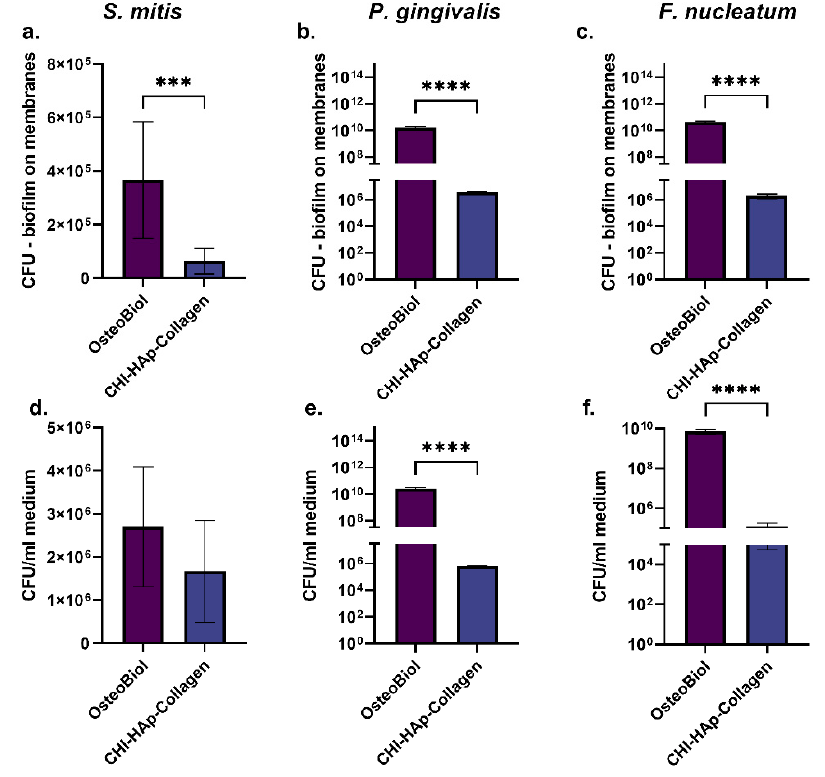
both types of collagen membranes showed signi fi cantly higher values of CFU on control membranes compared to CHI–HAp–collagen membranes for each monomicrobial bio fi lm (Figure 6). Additionally, the CFU count from the medium around both types of collagen membranes was higher for the medium around unmodi fi ed membranes for all species (results for P. gingivalis and F. nucleatum reached statistical signi fi cance).